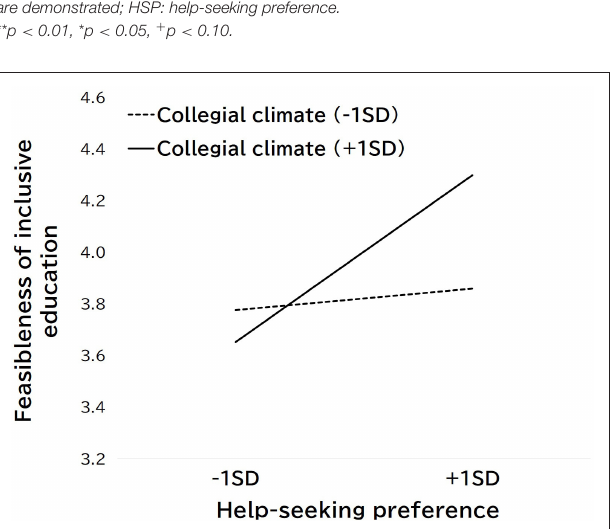
FIGURE 2 | Interaction effect of Japanese schoolteacher’s help-seeking preference and their perceived collegial climate (Dependent variable: feasibleness of inclusive